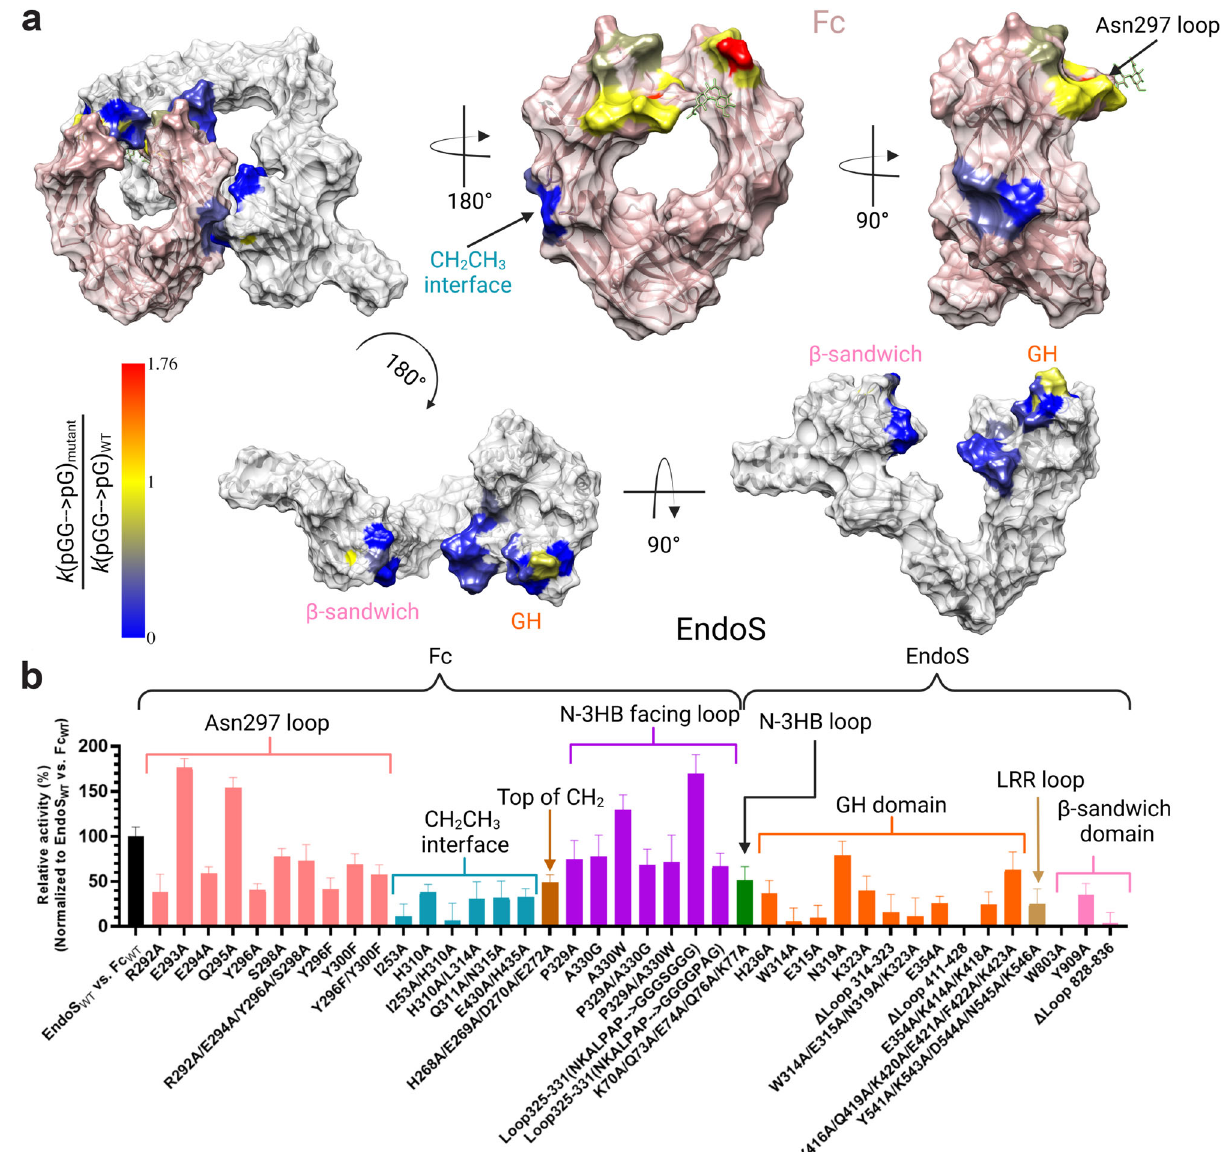
Fig. 3 | Alanine scanning mutagenesis of the EndoS-Fc interface. a Structure of the EndoS (gray) complexwith Fc(pink)in whichthe regions withalanine mutants are color coded based on the relative rates of removal of the N -glycans from Fc alanine mutants by EndoS and vice versa. The rates were measured via LC-MS kinetic analyses. Red indicates the largest increase in hydrolytic activity while blue indicates no hydrolytic activity. b Rates of removal of the fi rst glycan of Fc and Fc